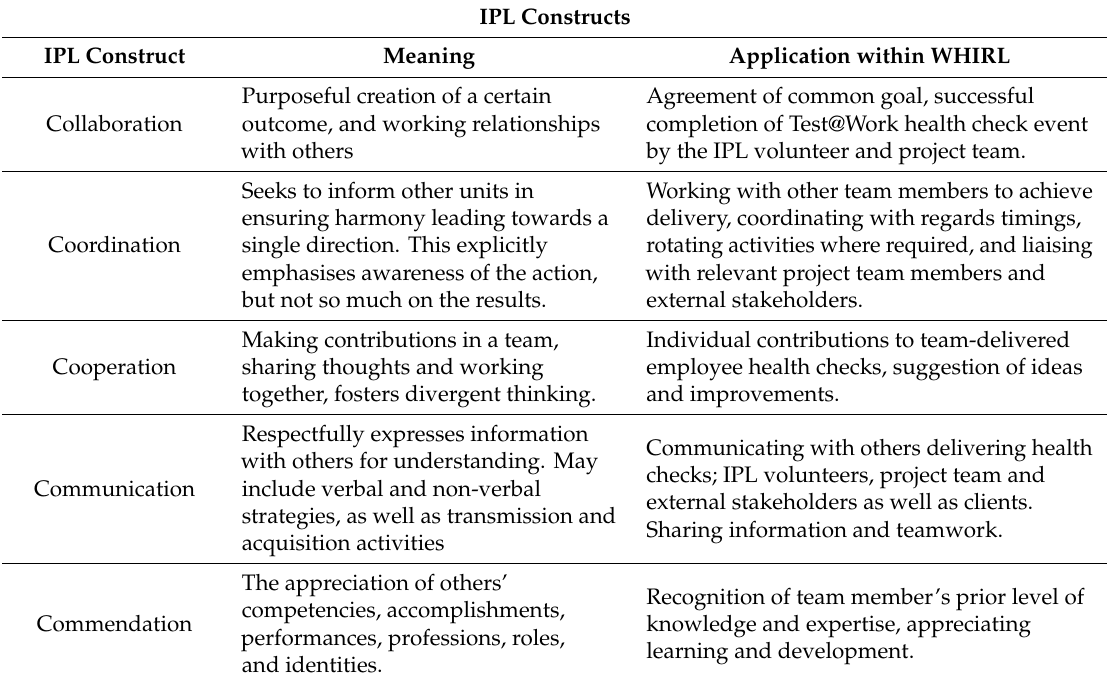
Table 2. IPL constructs and application within